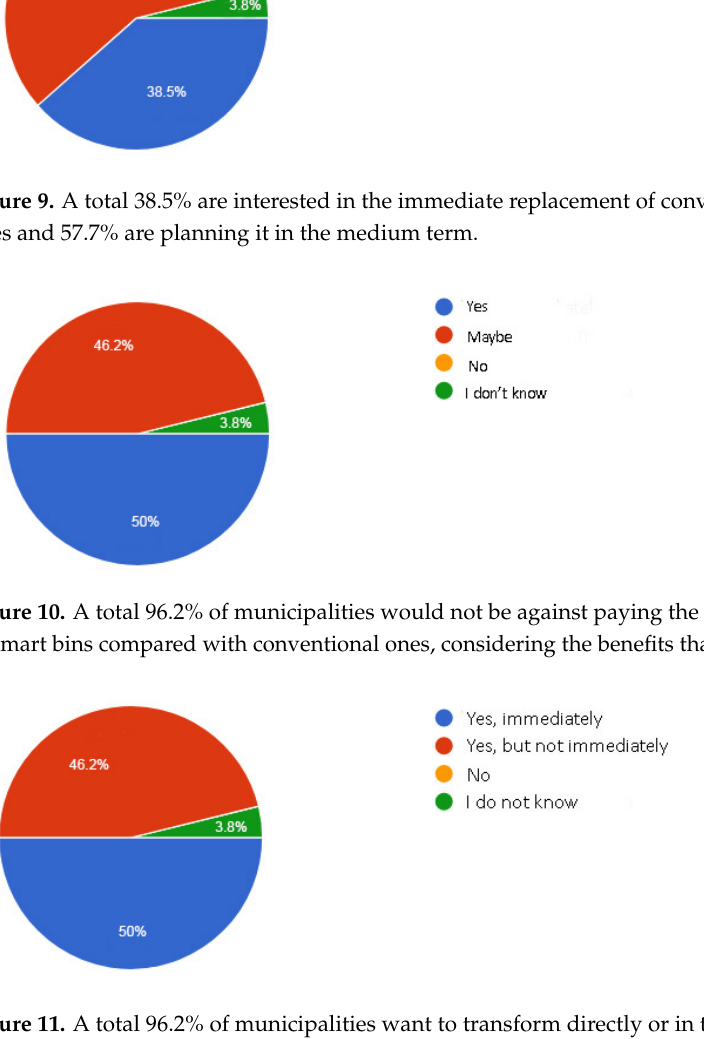
Figure 11. A total 96.2% of municipalities want to transform directly or in the medium term plan to smart city practices (smart